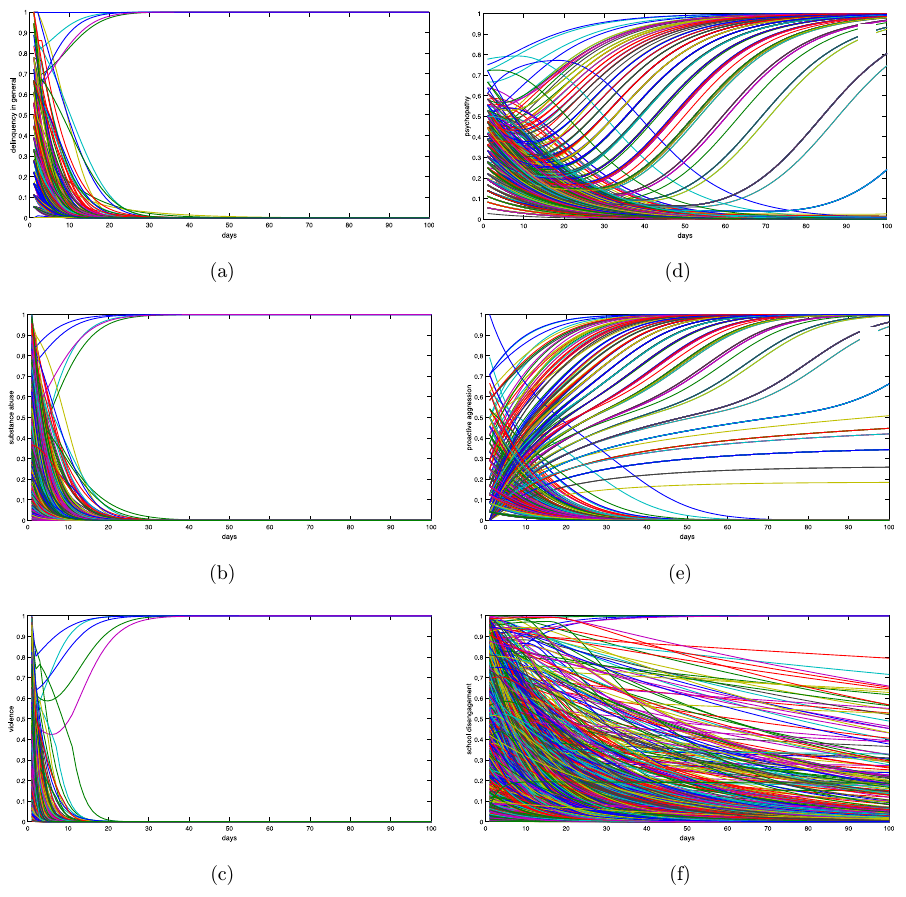
Fig. 4. The fast time evolution of (a) DG, (b) SA, (c) VI, and slow time evolution of (d) PC, (e) PA, (f) SD for N ¼ 1003 agents in our